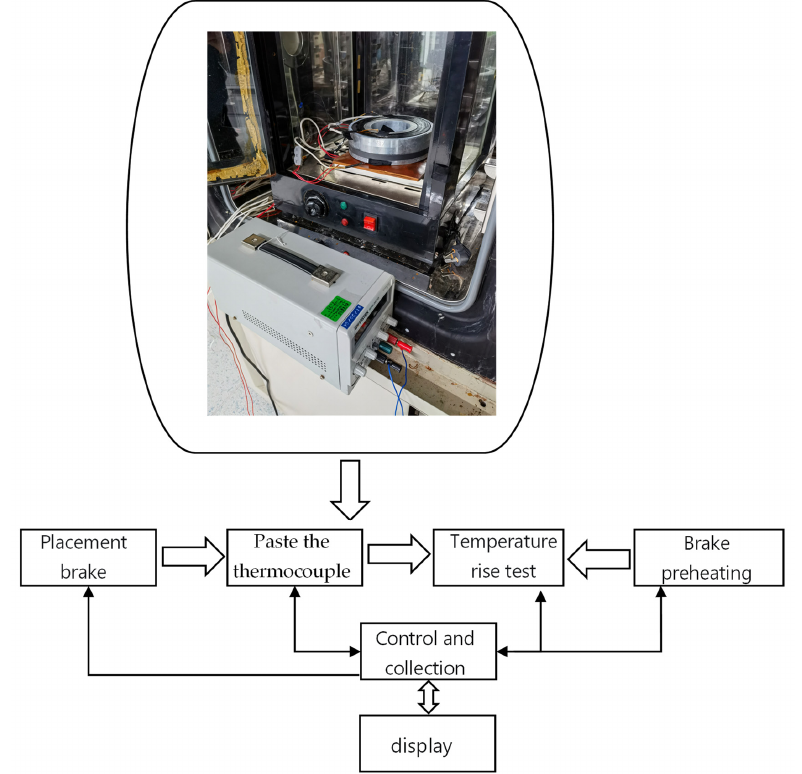
Figure 13. Working principal diagram of temperature rise test platform.